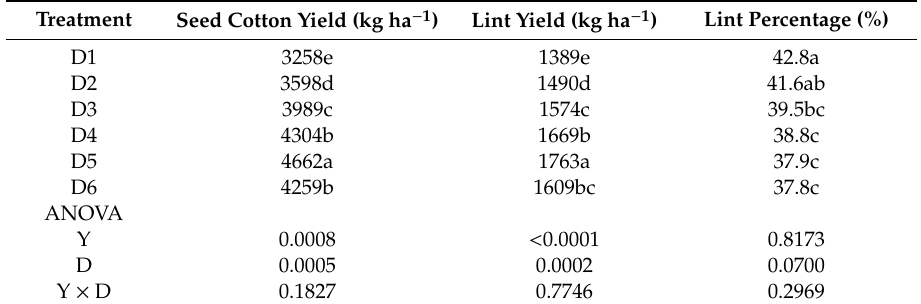
Table 2. Comparison of seed cotton and lint yield of various plant densities in 2016 and 2017 in the cotton growing